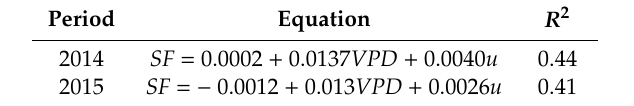
Figure 5. Hysteresis loops between transpiration ( T r ) and solar radiation ( R s ), air temperature ( T ), and vapor pressure deficit ( VPD ) in ( a – c ) 2014 and ( d – f ) 2015. The black, blue, green, and red cycles represent transpiration in the stand, H. ammodendron , N. tangutorum , and C. mongolicum , respectively. Table 5. Multivariate linear equation between nocturnal sap flow and solar radiation, air temperature and vapor pressure deficit.